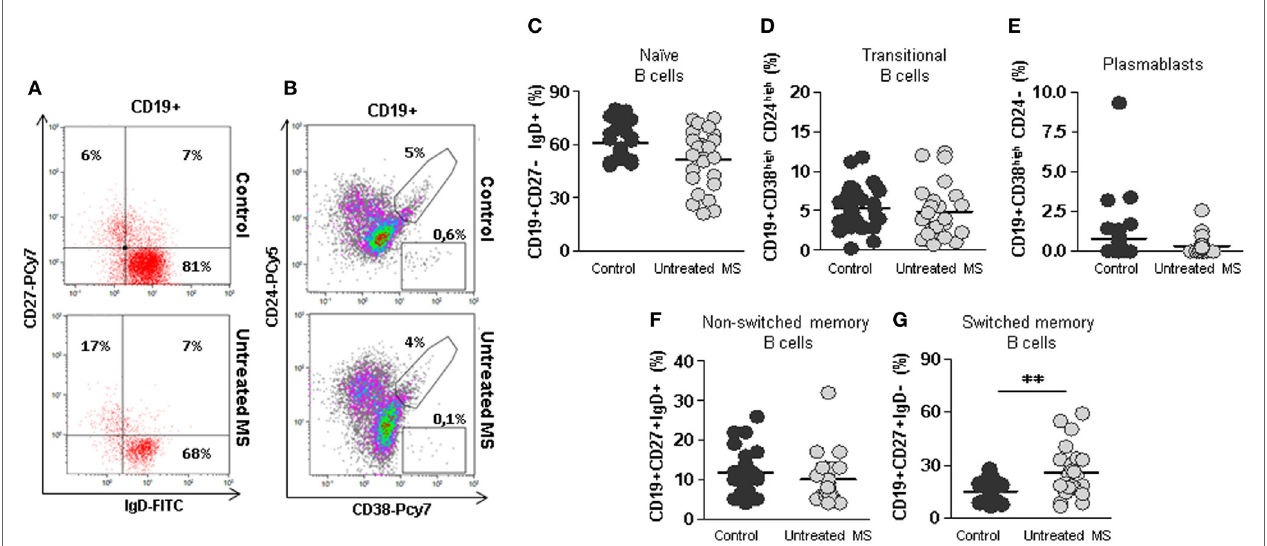
FigUre 1 | Subpopulations of B cells from untreated multiple sclerosis (MS) patients. (a) Dot plots of the percentages of peripheral naïve CD19 + CD27 − IgD + (lower right quadrant), non-switched memory CD19 + CD27 + IgD + (upper right quadrant), and switched memory CD19 + CD27 + IgD − (upper left quadrant) B cells on total CD19 + gated B cells from a representative untreated MS patient (lower row) and control (upper row). (B) Dot plots of the percentages of peripheral transitional CD19 + CD38 high CD24 high B cells on total CD19 + gated B cells from a representative untreated MS patient (lower row) and control (upper row). (c–g) Percentages of naïve CD19 + CD27 − IgD + , transitional CD19 + CD38 high CD24 high , plasmablasts CD19 + CD38 high CD24 − , non-switched memory CD19 + CD27 + IgD + , and switched memory CD19 + CD27 + IgD − B cells from controls (dark gray circles) and untreated MS patients (light gray circles). Mann–Whitney U -test p -values: ** p <